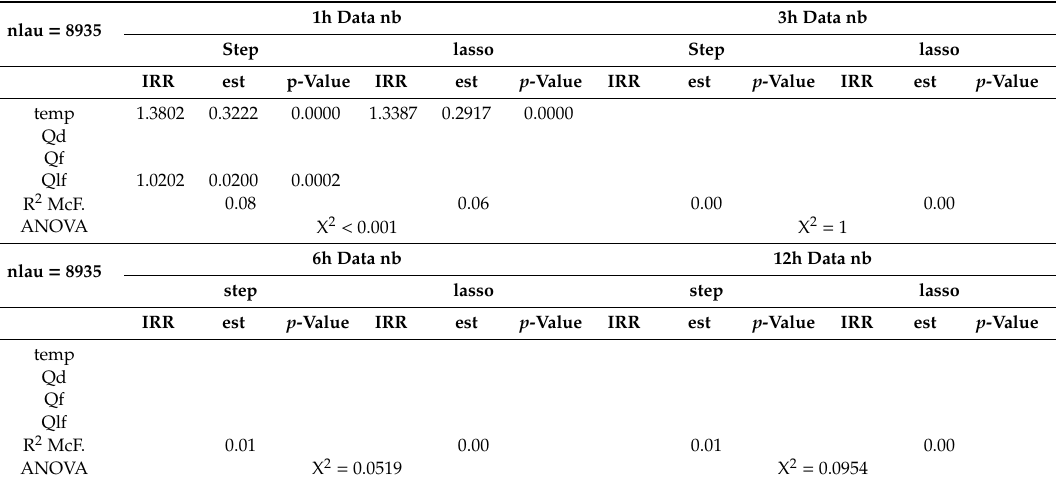
Table 7. Results of variable selection of A. alburnus (nlau).